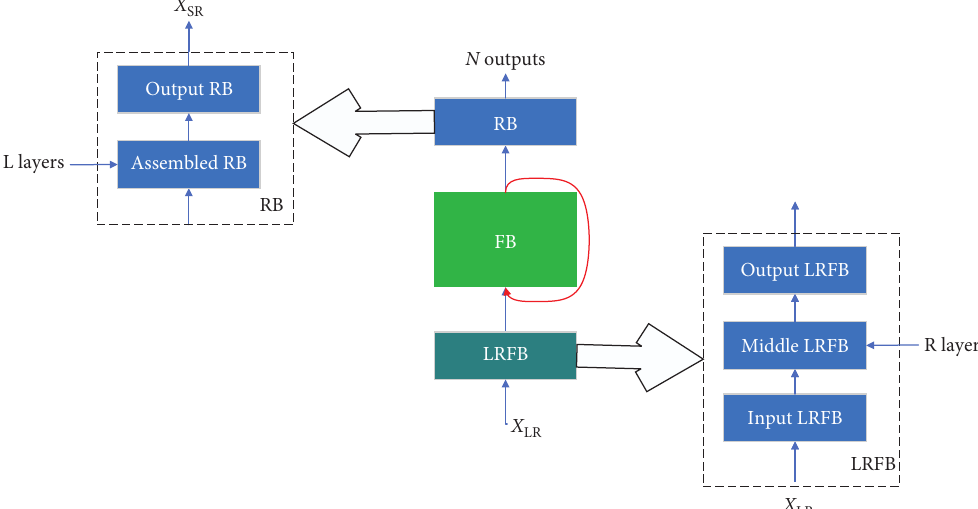
Figure 2: The structure of our proposed Improved Superresolution Feedback Network (ISRFN).